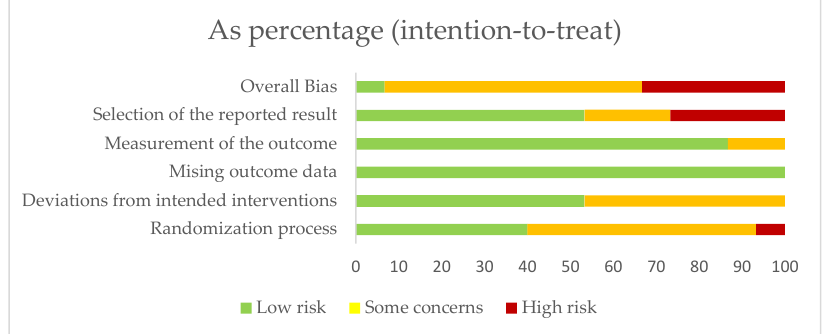
Figure 2. Risk of bias assessment in randomized controlled trials (RoB2).